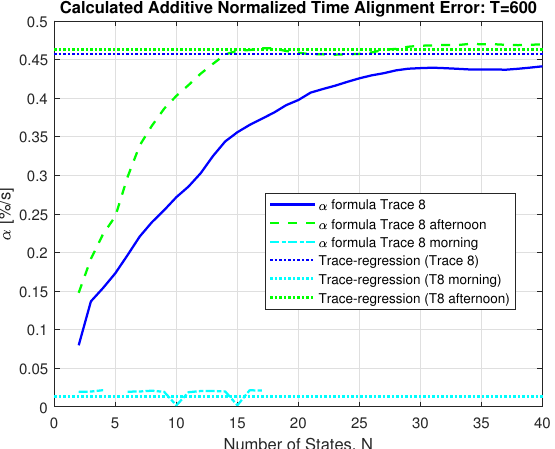
Figure 4. Resulting calculated α ( T = 600 s) when fitting a MMP-GapT model to Trace 8 for increasing number, N , of Markov model states—those discretize the data. Shown also are the results for the